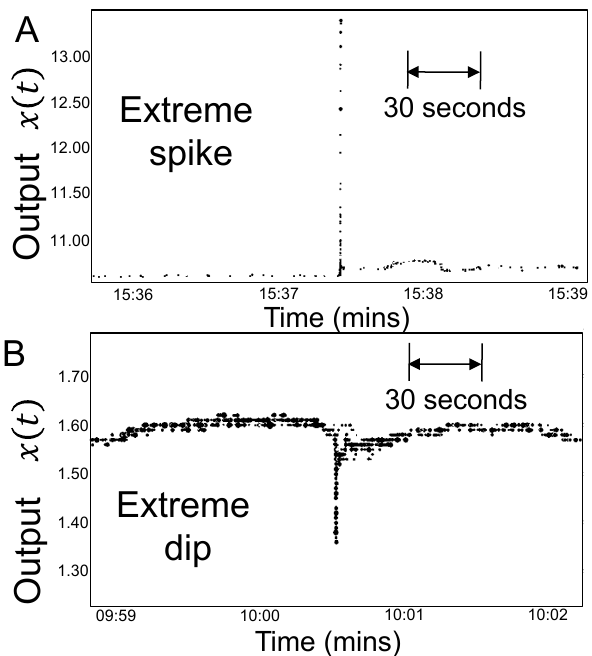
Figure 1. Subsecond tsunamis from a real-world decentralized, all-electronic system. The data comes from the U.S. network of market exchanges. ( A ) an example of an extreme spike in the price of a particular stock. The points are discrete since each corresponds to a specific event (i.e., a new trade). This is consistent with our decision to focus on discrete-time models in this paper. The number of sequential up ticks is 31, and the price change is +2.75. The duration is 25 ms (i.e., 0.025 s). The percentage price change upwards is 26% (i.e., spike size is 0.26 expressed as a fraction). The size of the dots in price chart are proportional to volume of trade; ( B ) an example of an extreme dip in the price of a particular stock. The number of sequential down ticks is 20, and the change in output (i.e., price change) is − 0.22. The duration is 25 ms (i.e., 0.025 s). The percentage price change downwards is 14% (i.e., dip size is 0.14 expressed as a